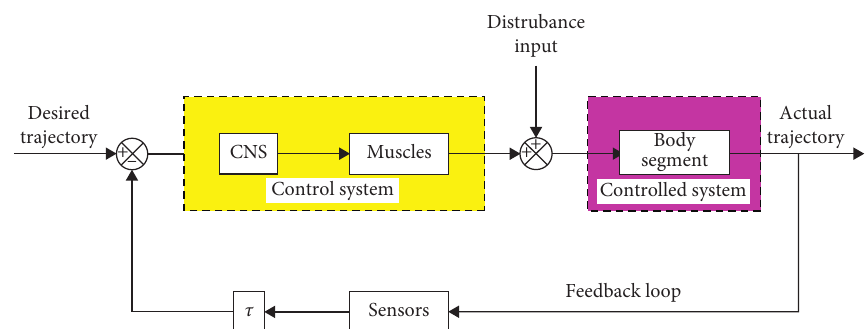
Figure 1: Conceptual scheme of the motion control of a musculoskeletal system